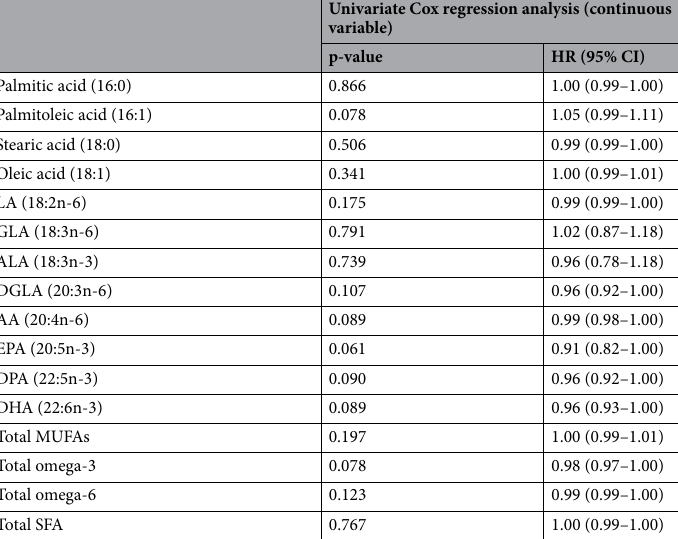
Cox regression analysis (categorical